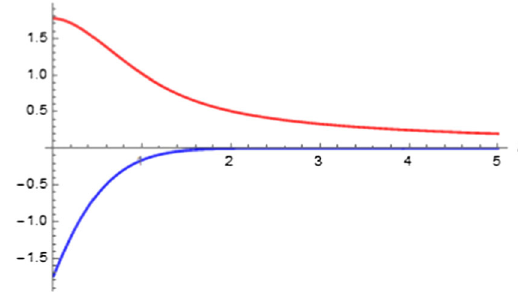
( a ) The real (blue line) and imaginary (red (b) The real (blue line) and imaginary (red line) parts of the commutator as a function line) parts of the commutator as a function of θ for the illustrative case r = 1 of r for the illustrative case θ = 1 Fig. 1 A graphical display of the behaviour of the polar commutator for illustrative domains of r and θ as discussed in the main